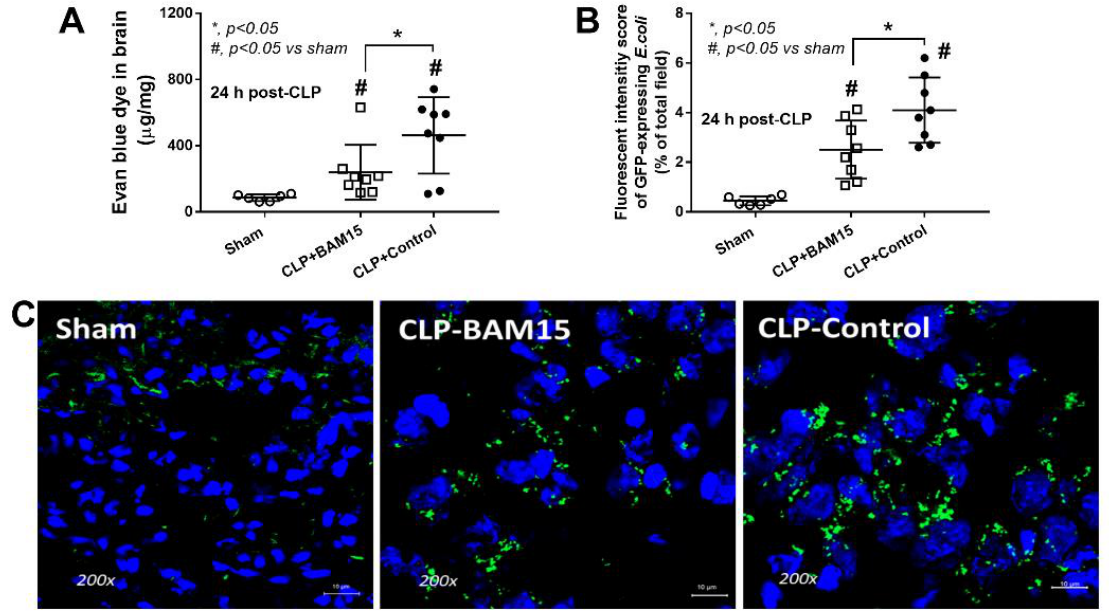
Figure 4. The abnormal permeability in the brain (Evan’s blue dye assay) ( A ) and abundance (fluorescent intensity) of green-fluorescent-producing (GFP) E. coli in the mouse brains at 24 h post-surgery with oral GFP- E. coli administration at 6 h prior to the operation (sham or CLP) with the representative fluorescent figures ( B , C ) are demonstrated ( n = 6–8/group). #, p < 0.05 vs. Sham; *, p < 0.05 vs. the indicated groups as determined by ANOVA with Tukey’s analysis. Data from sham mice with BAM15 are not demonstrated due to the non-significant difference to the sham group.